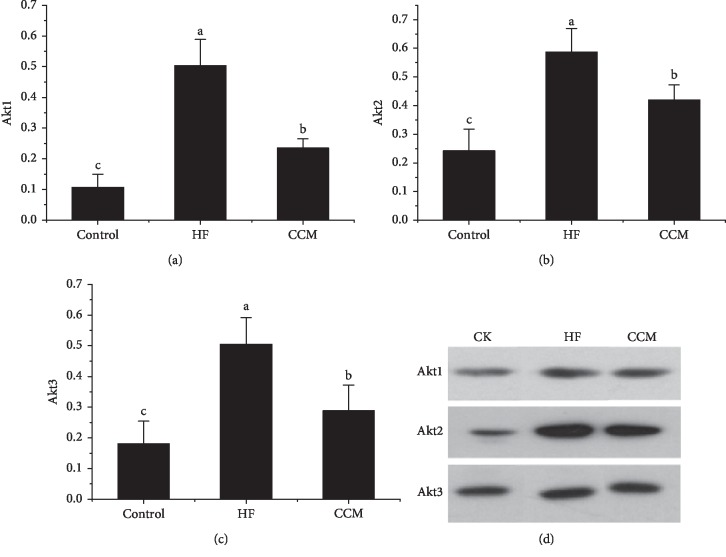
Effects of cardiac contractility modulation (CCM) on Akt1, Akt2, and Akt3 expression in different rabbit myocardial tissues under different treatments. (a) Akt1 expression; (b) Akt2 expression; (c) Akt3 expression; and (d) western blot images of Akt1, Akt2, and Akt3. CK, control group; HF, heart failure. Different lower letters above each boxplot showed the significant differences at p < 0.05.